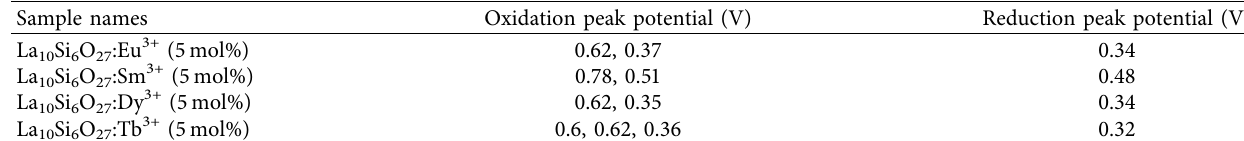
10 Si 6 O 27 electrode material with various